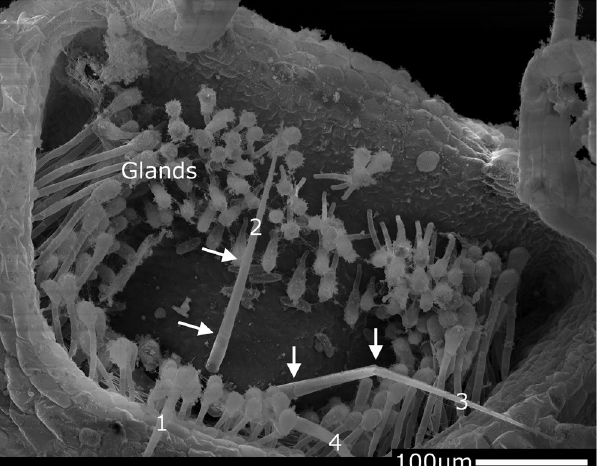
Figure 4. Trigger hair bending deformation. SEM micrograph of the outer trapdoor surface. A multitude of glands of uncertain function (cf. ref. 2) as well as the four trigger hairs (1–4) – which protrude from the door – are well visible. The arrows in trigger hairs 2 and 3 indicate cell-cell-junctions, which we hypothesize to act as hinge